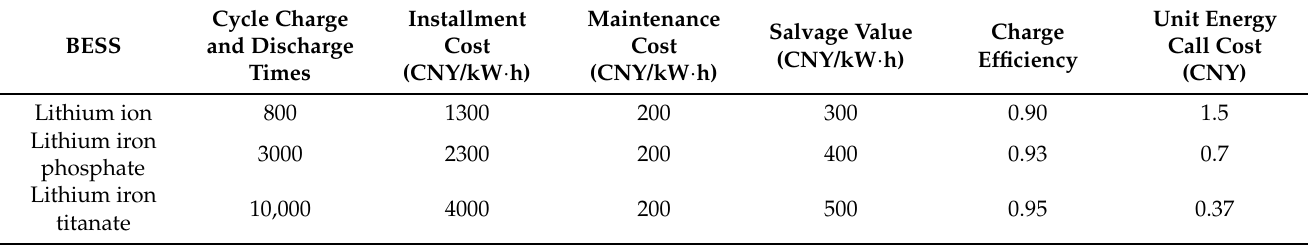
Table 4. Cost of